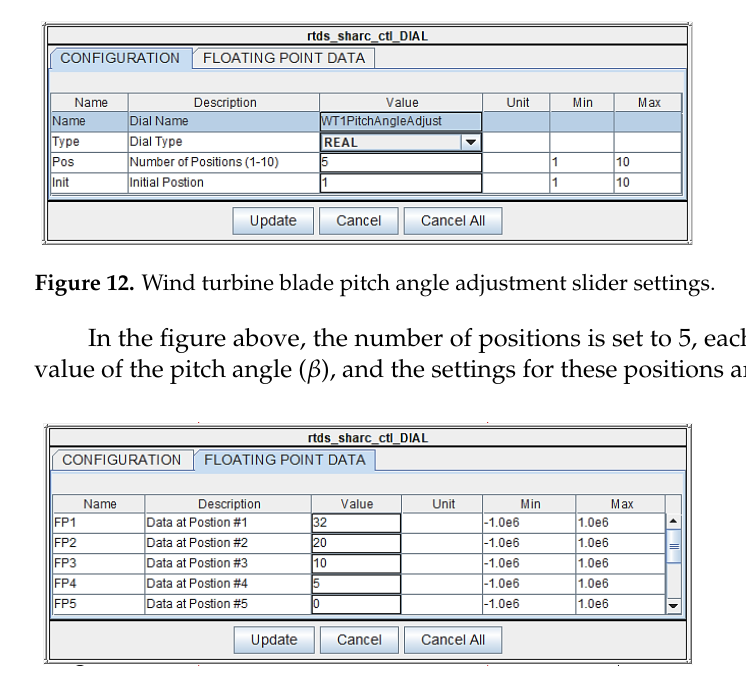
Figure 11. Wind speed adjustment settings.